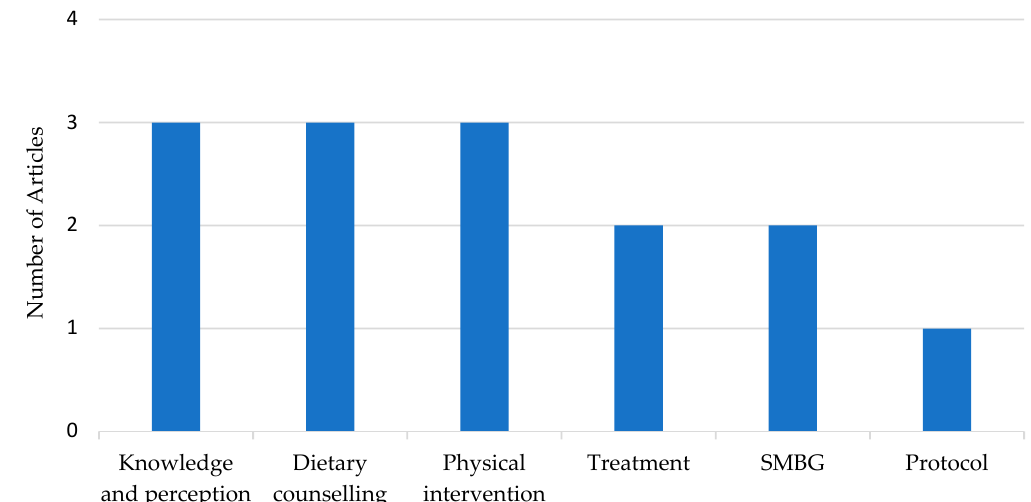
Figure 7. Number of articles assessing the management of GDM among Southeast Asian women. Note: SMBG; Self- monitoring blood glucose.